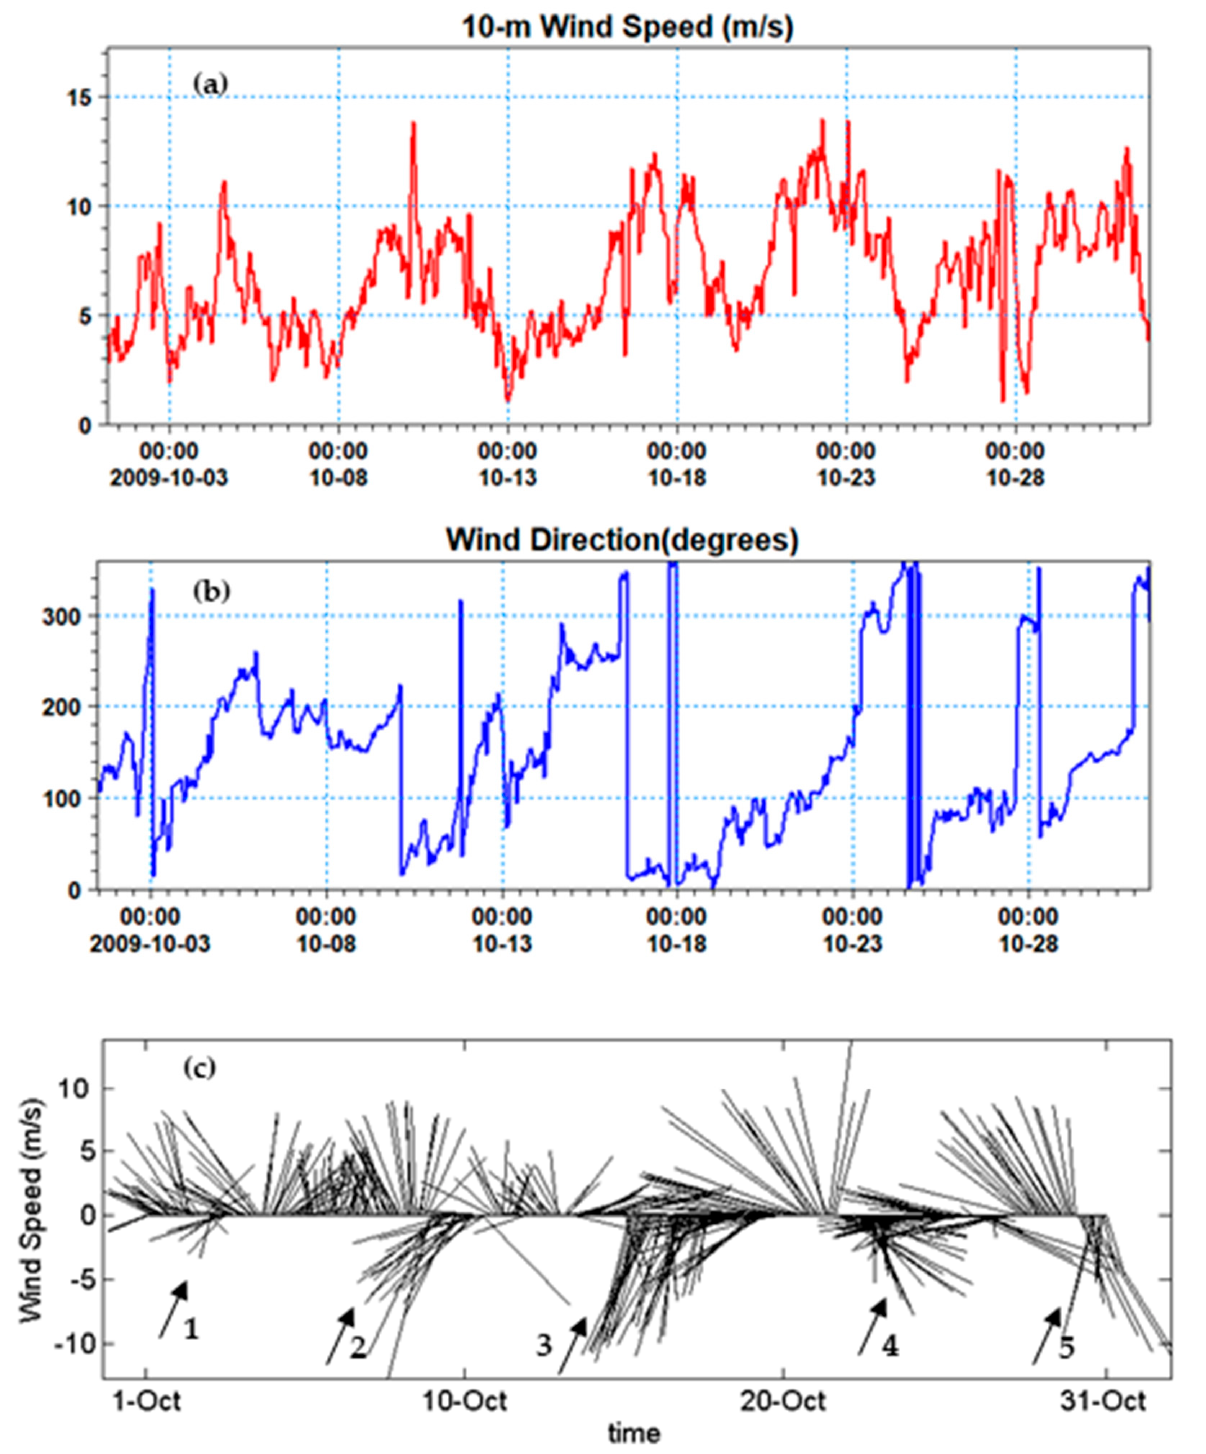
Figure 5. Time series of wind vectors measured at CSI-6 during October 2009, ( a ) wind speed, ( b ) wind direction, and ( c ) wind vectors. The numbered arrows in panel ( c ) show the approximate time corresponding to each of the five cold front events in October 2009.